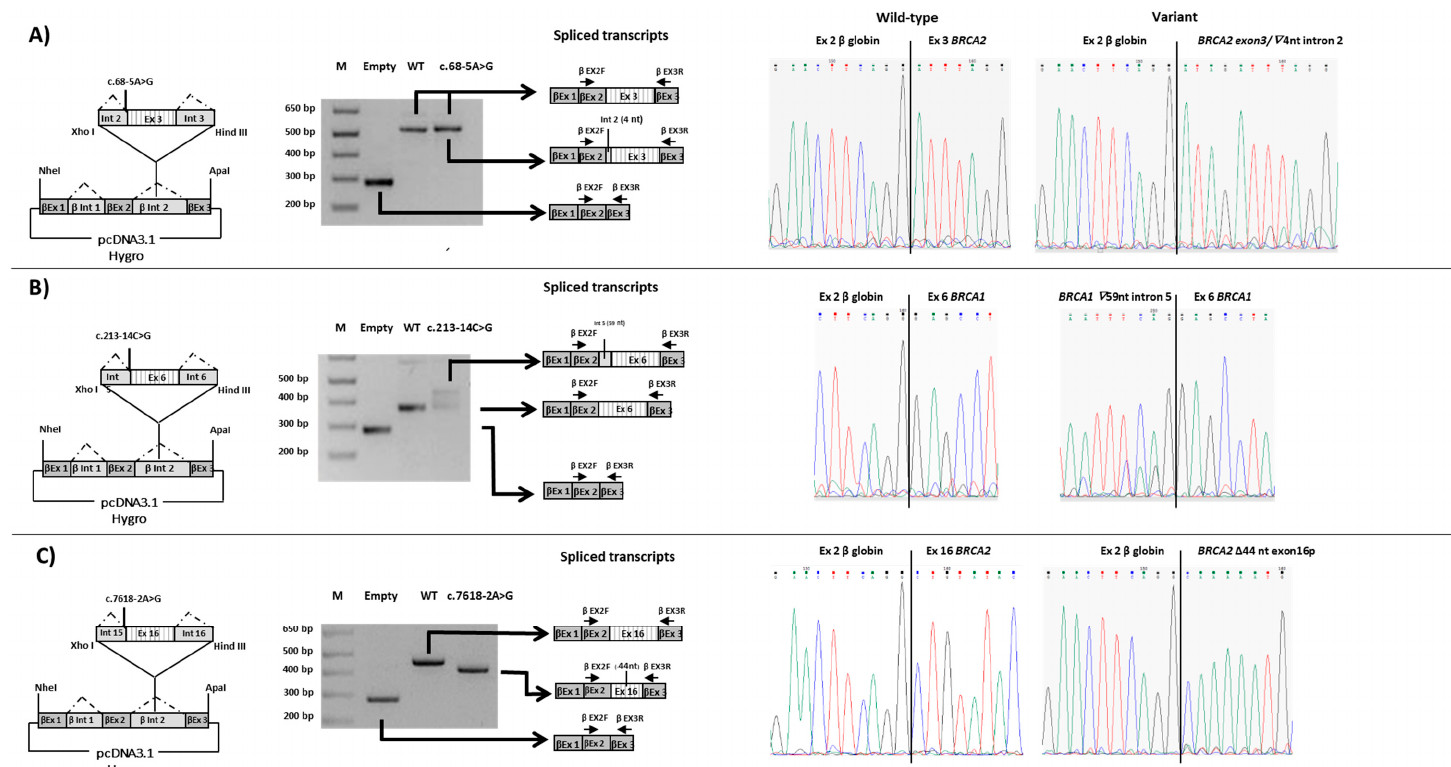
Figure 3. RT-PCR analysis of the BRCA1 and BRCA2 minigene constructs expressed in HeLa cells using vector specific primers. A schematic representation of the hybrid minigene constructs is depicted on the left; the dotted lines indicate normal splicing. Each construct contains the exon close to, or harboring the variant of interest and part of the upstream and downstream introns of BRCA1 or BRCA2 genes. Electropherograms of the spliced transcripts are shown on the right. ( A ) The construct contains exon 3 of the BRCA2 gene. c.68-5A>G, construct containing the c.68-5A>G variant. ( B ) The construct contains exon 6 of the BRCA1 gene. c.213-14C>G, construct containing the c.213-14C>Gvariant. ( C ) The construct contains exon 16 of the BRCA2 gene. c.7618-2A>G, construct containing the c.7618-2A>G variant. M, 1 kb plus molecular marker (Invitrogen); Empty, empty β -globin-pCDNA3.1 vector; WT, wild-type construct.